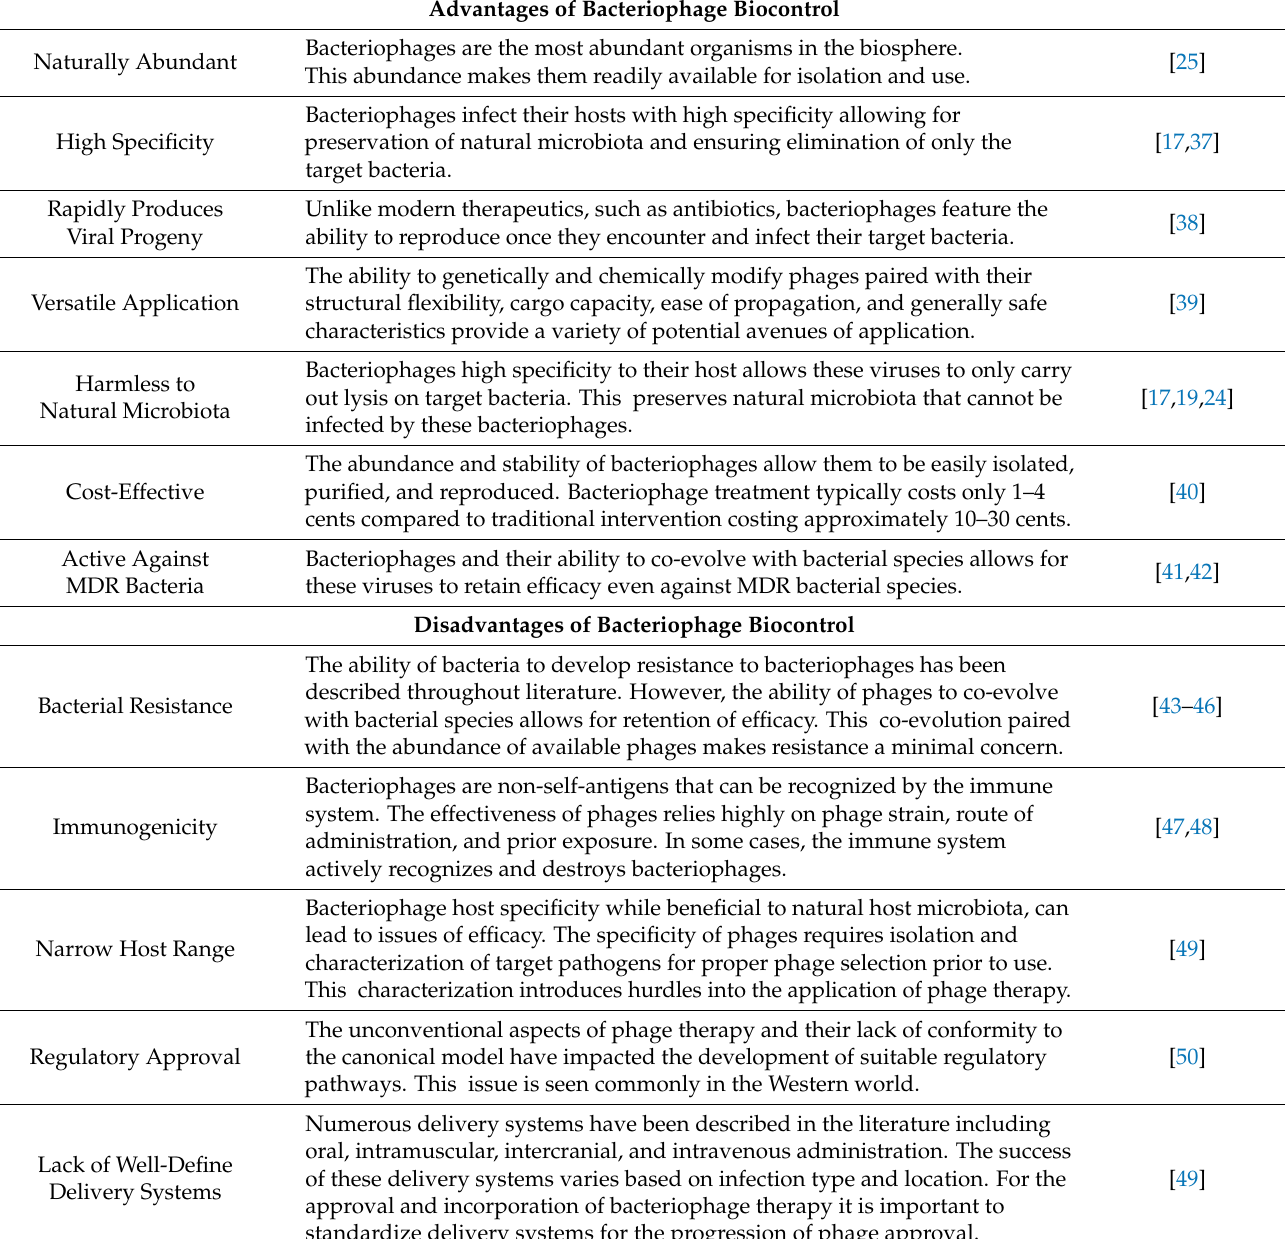
Table 1. General Advantages (Top) and Disadvantages (Bottom) of Bacteriophages as Biocontrol